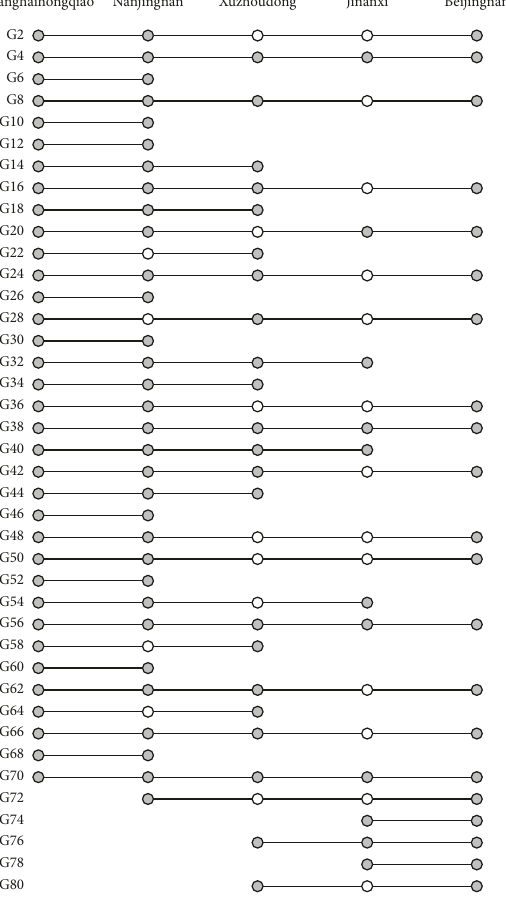
Figure 4: The stopping plan of existing trains in the experiment.